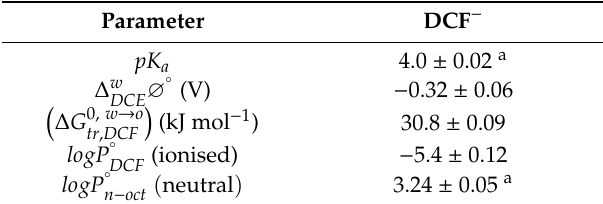
Figure 4. ( a ) Background-subtracted CVs of 20 to 100 µM (as indicated arrow) DCF (cid:2879) transfer, in increments of 20 µM, at scan rate 10 mVs − 1 . ( b ) The calibration curve of the limiting currents (forward scan) and peak currents (reverse scan) versus DCF (cid:2879) concentrations( c ) voltammograms of 100 µM ( black line) DCF (cid:2879) and 60 µM (gray line) TMA + . Table 1. Formal transfer potential, the standard Gibbs energy of transfer and the partition coefficient of ionized diclofenac drug in the water/1,6-DCH system